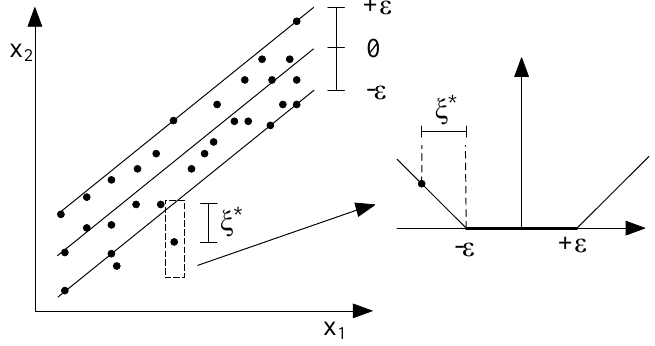
Figure 1. Tolerable bandwidth of Support Vector Machine (SVM).